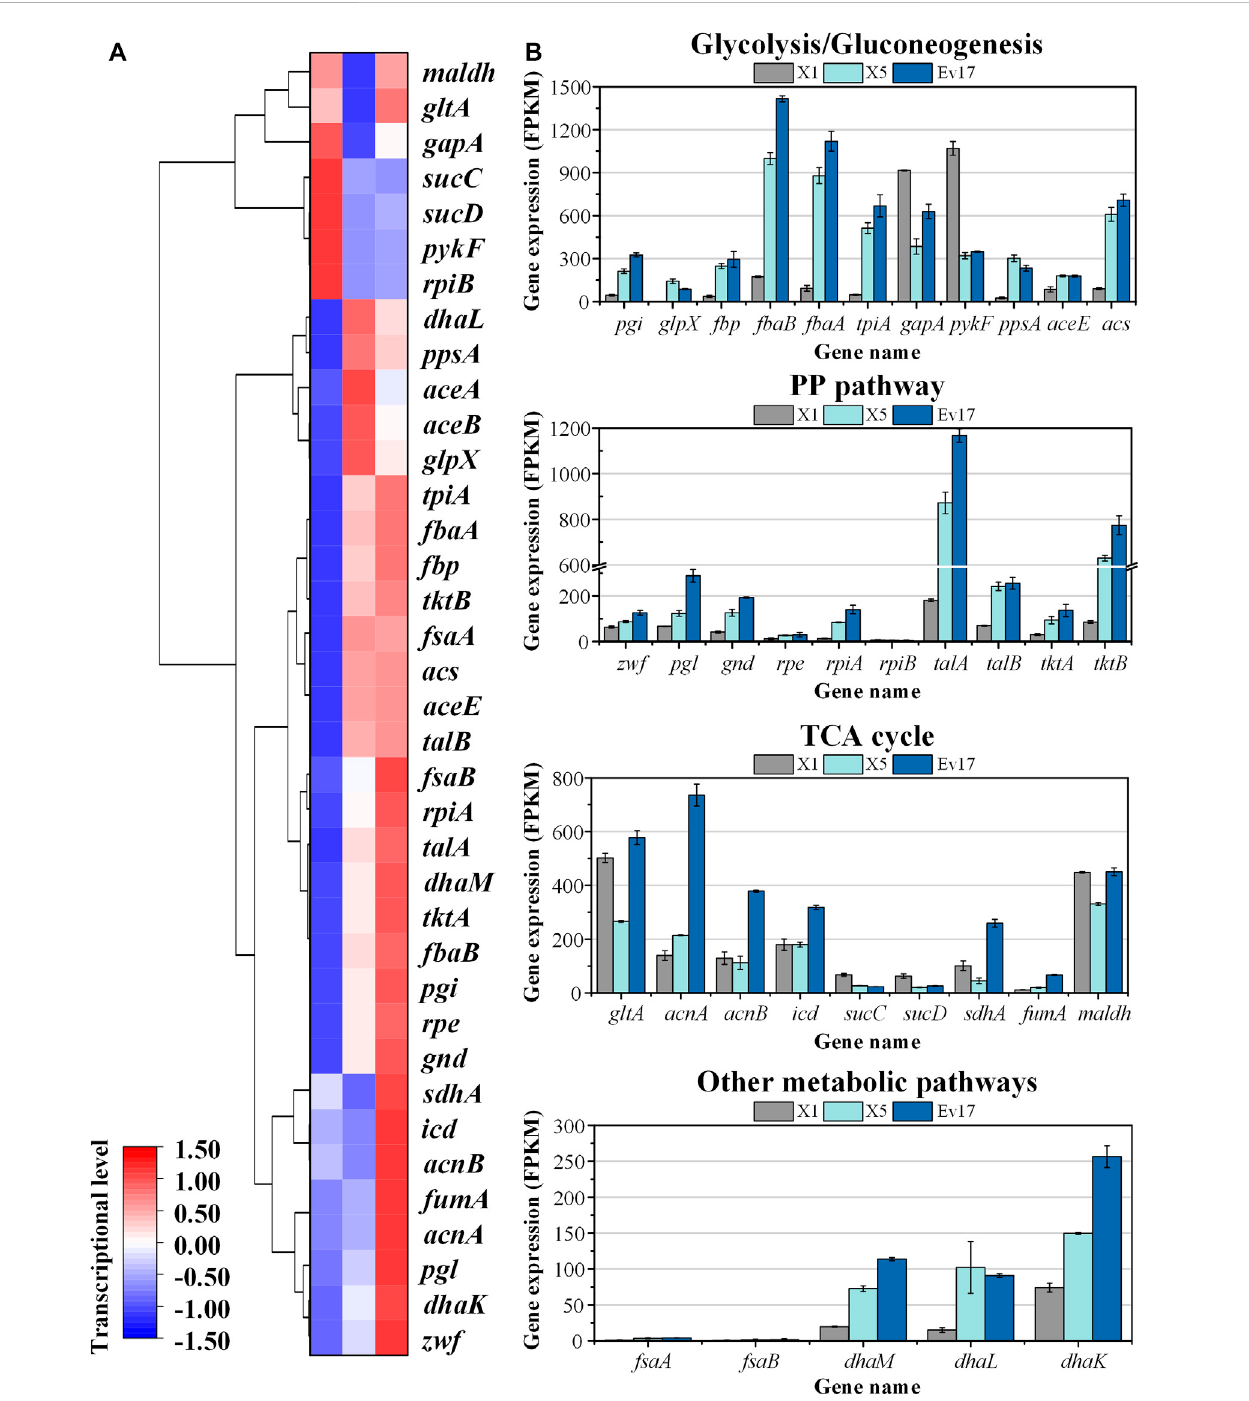
Transcriptomics analysis of strain X1, X5, and Ev17. (A) Heat map and hierarchical clustering of differentially expressed genes. (B) Gene expression of glycolysis/gluconeogenesis pathways, TCA cycle, PP pathway and other metabolic pathways of strain X1, X5, and Ev17. The transcriptional level (FPKM) has been normalized ( n =